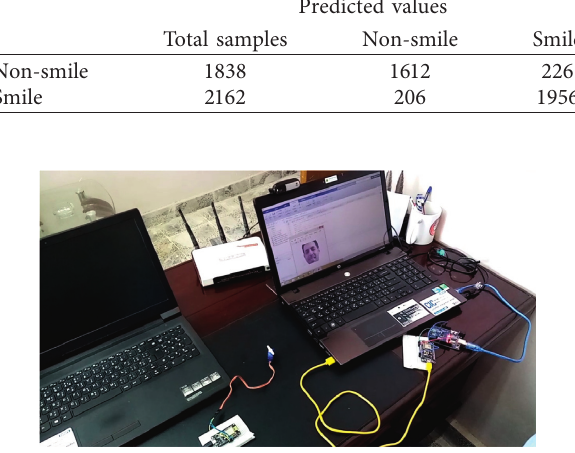
Figure 5: Communication between the HTTP server (right PC) and HTTP client (left PC); smiling state with the vertical motor position.